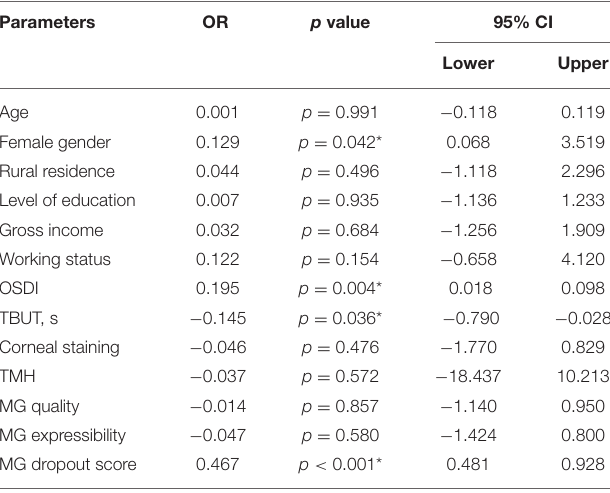
TABLE 4 | Multivariate logistic regression analysis between sleep quality (PSQI score), demographics and dry eye parameters.